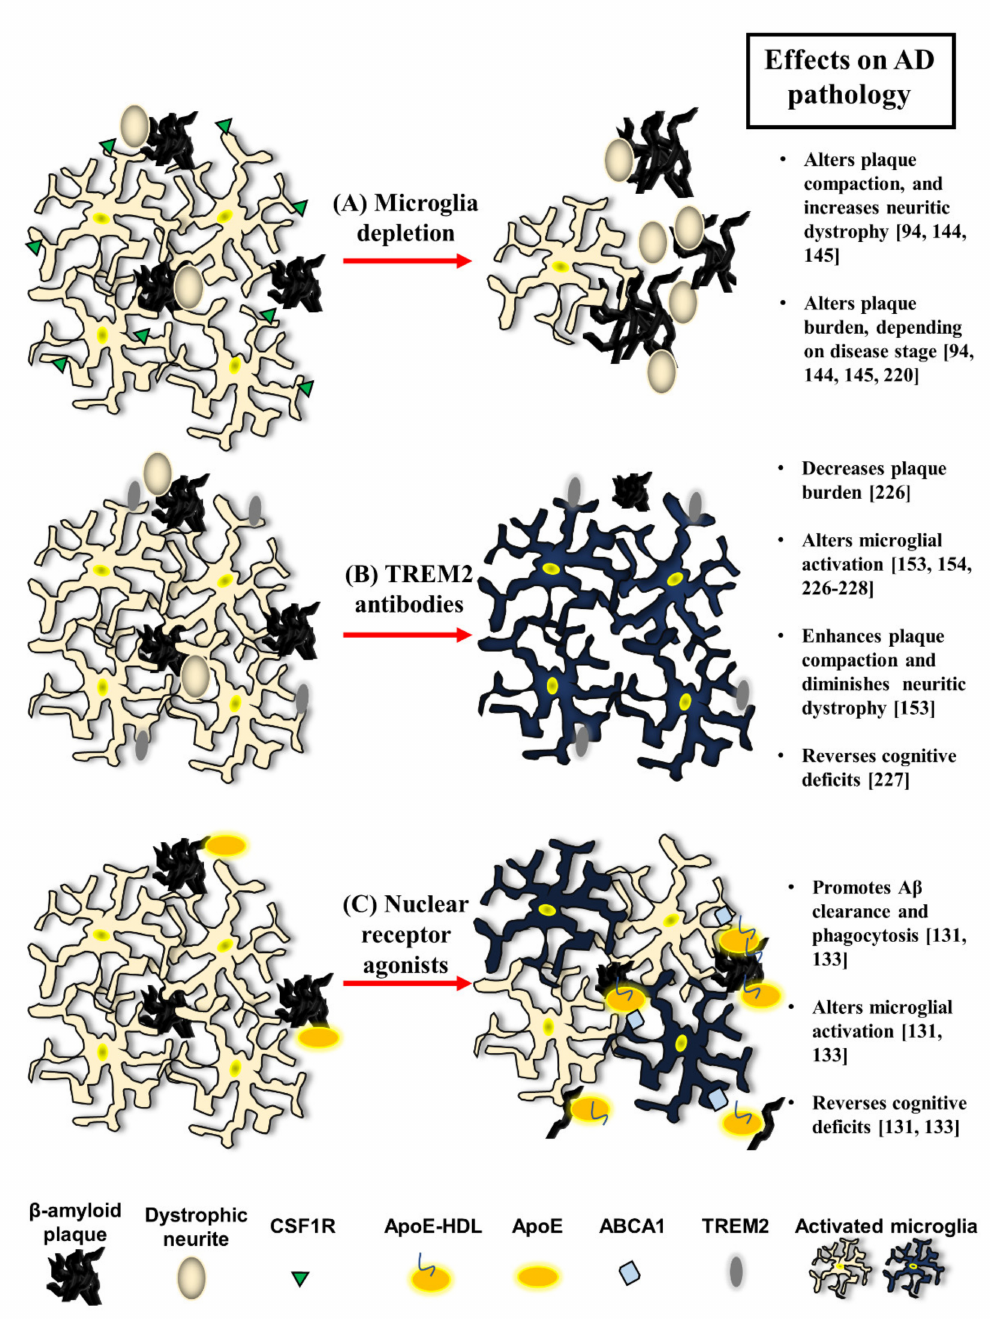
Figure 2. Microglia-directed manipulations and therapeutics modify pathology in AD. Microglia can be targeted through three generalized paradigms. ( A ) In microglia depletion models, CSF1R inhibitors kill microglia. Depletion can alter plaque compaction, enhance neuritic dystrophy and modify plaque burden depending on the disease stage. ( B ) TREM2 antibodies have been shown to promote microglial activation profiles amenable to phagocytosing plaques, enhancing plaque compaction, abrogating neuritic dystrophy and ameliorating cognition. ( C ) Nuclear receptor agonists promote upregulation of lipoprotein ApoE, its lipid transporter ABCA1 and production of ApoE-HDLs, the former of which promotes A β clearance by microglia. Nuclear receptors also enhance A β phagocytosis, alter microglia polarization and reverse cognitive deficits in various mouse models of AD. In this figure, references are denoted after the effects on AD pathology of each